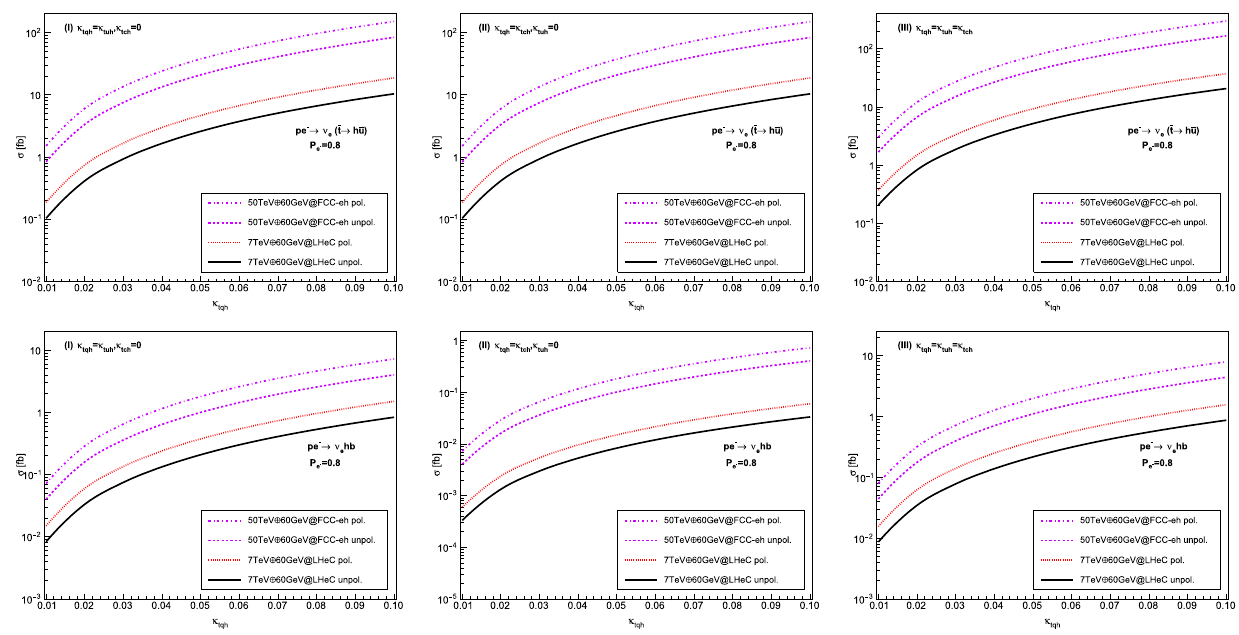
Fig. 3 The cross sections for signal I e − p → ν e ¯ t → ν e h ¯ q and signal II e − p → ν e hb as a function of the top–Higgs FCNC couplings κ tqh at the 7 TeV LHeC and 50 TeV FCC-eh. The electron beam is 60 GeV short-dash-dotted violet curves and long-dash-dotted green ones are for bakt, bakh, bakz and bakjjj, respectively. All the plots are unit normalized. The results are for signal I at the 50 TeV ⊕ 60 GeV@FCC-eh, while for the results at the 7 TeV ⊕ 60 GeV@LHeC we can get similar ones, which are not